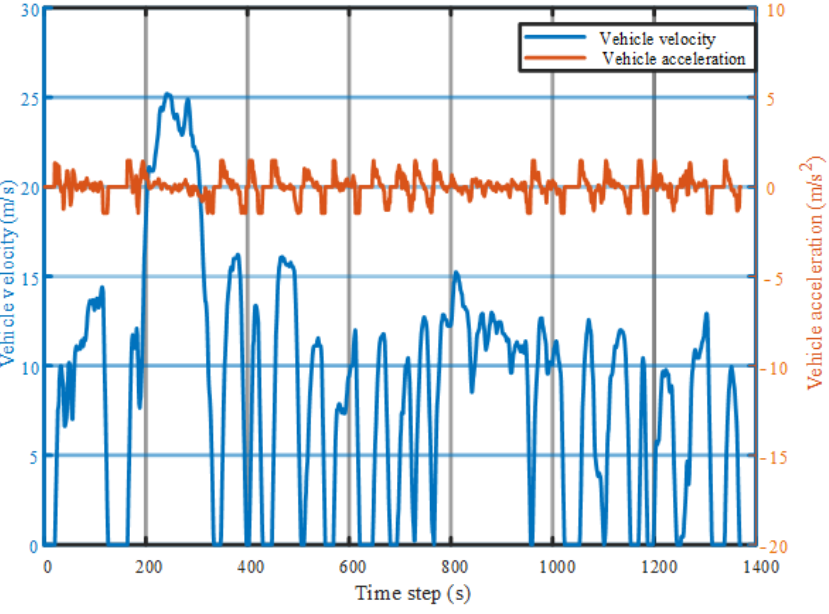
Figure 7. The velocity and acceleration of the